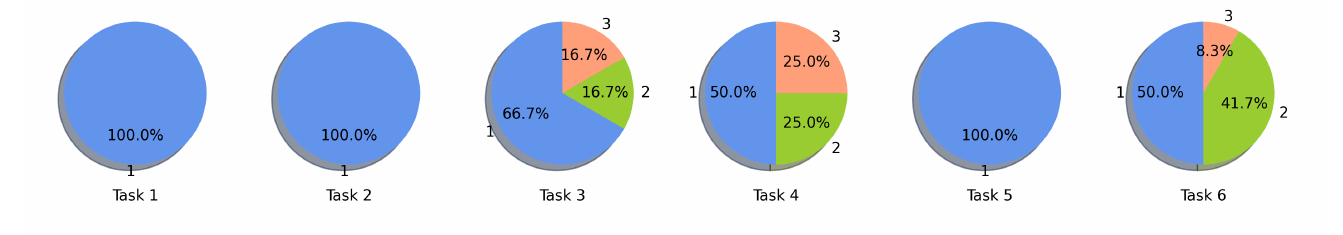
Figure 10. Ratio of QR scans to set position by task. The category values represent the number of QR scans required to complete the navigation.